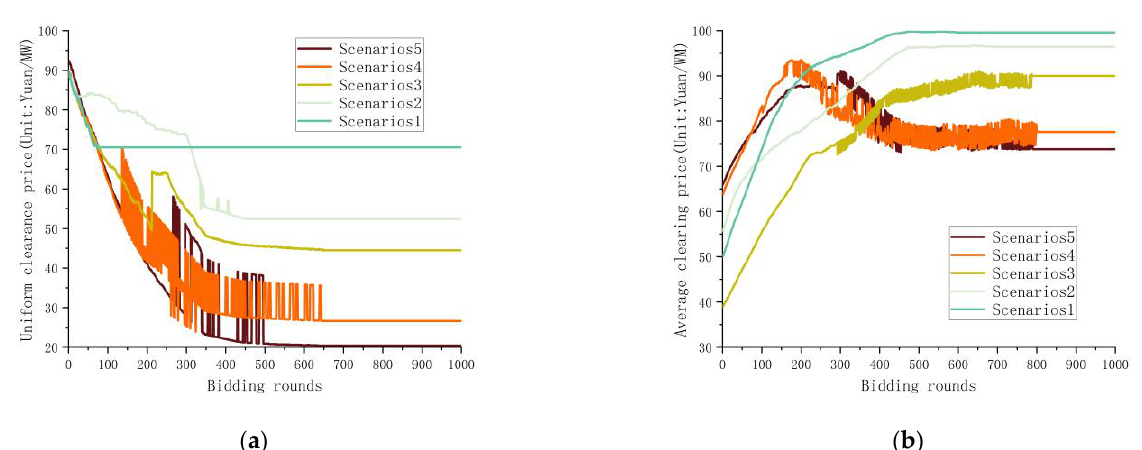
Figure 5. Sichuan uses the PAB pricing mechanism to compare unit price and performance index under scenario 5.